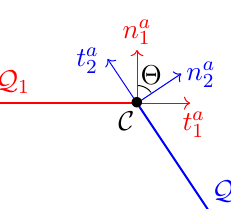
Figure 17. The normal and tangent vectors for two branes Q 1 and Q 2 located at their shared corner C . Note that for either brane, the corresponding normal and tangent vectors are orthogonal. The normal vectors of the two branes form an angle Θ